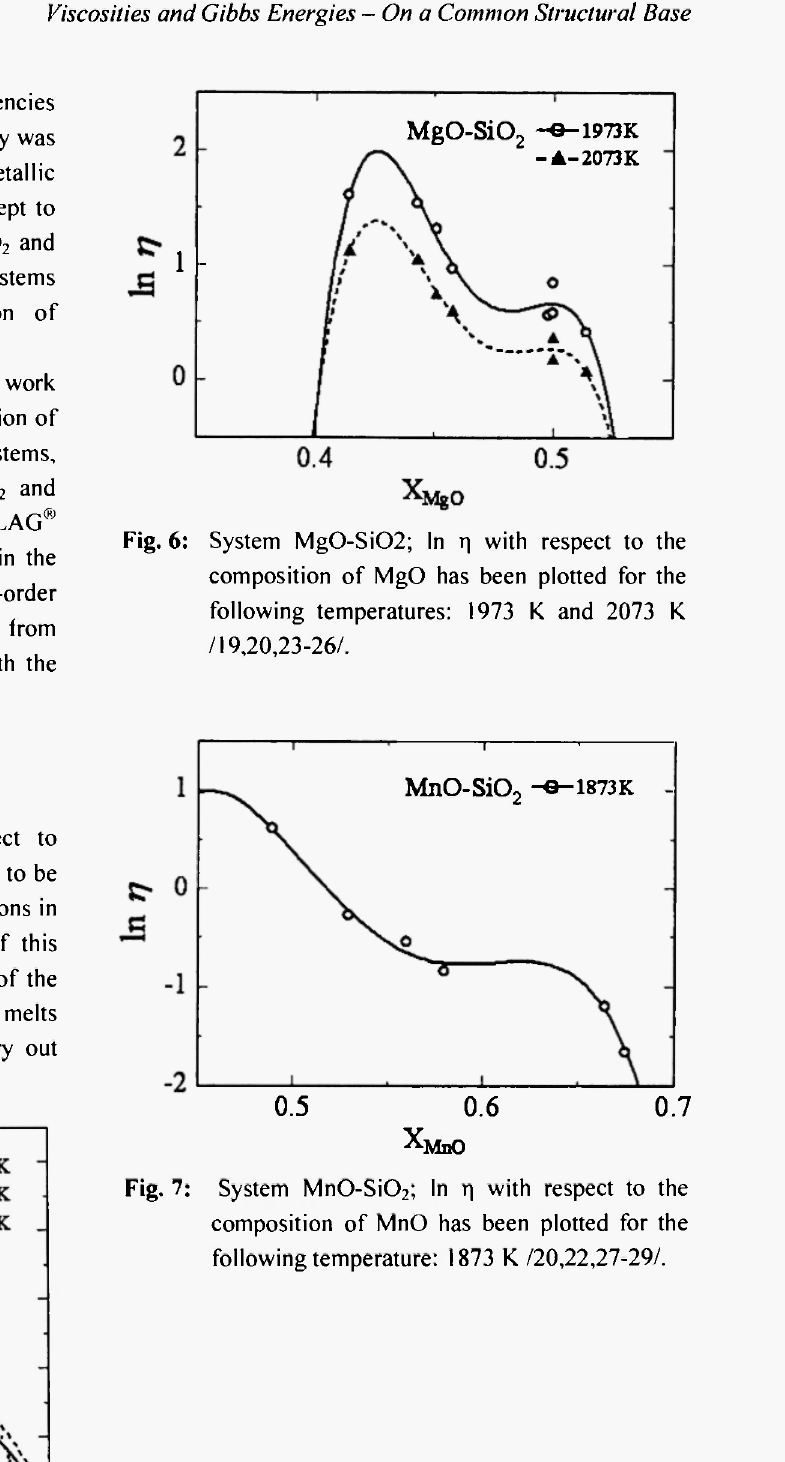
Fig. 5: System CaO-SiO,; In η with respect to the composition of CaO has been plotted for the following temperatures: 1823 K, 1923 Κ and 2023 Κ / 17-22/.